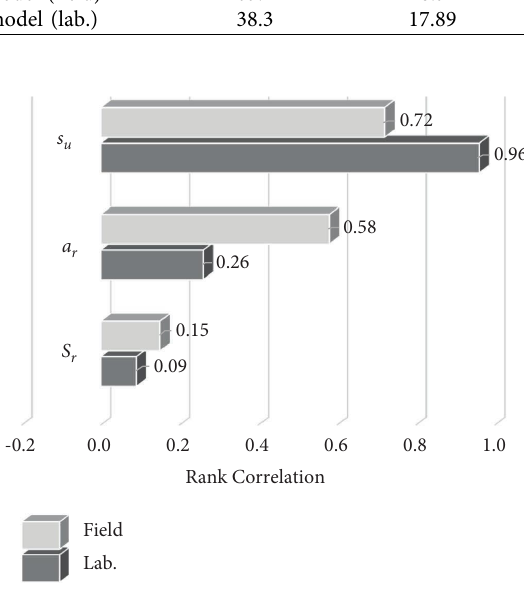
Figure 8: Tornado diagram of relative infuence of the input variables on MLR